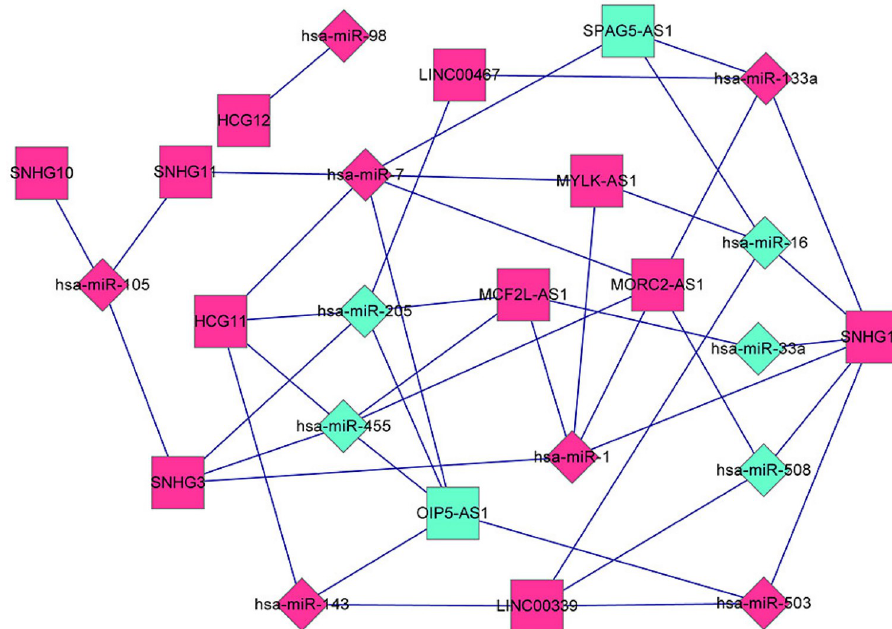
Fig 5. DEL–DEM regulatory network in alcohol-related EC progression. All the screened DELs were uploaded to both miRcode and starBase databases to predict lncRNA–miRNA interactions, of which 44 lncRNA–miRNA interactions involving DEMs were screened. The network was visualized based on the 44 lncRNA–miRNA interactions. Diamond and square nodes represent miRNAs and lncRNAs, respectively. Red and green colors represent upregulation and downregulation, respectively. DEL, differentially expressed lncRNA; DEM, differentially expressed